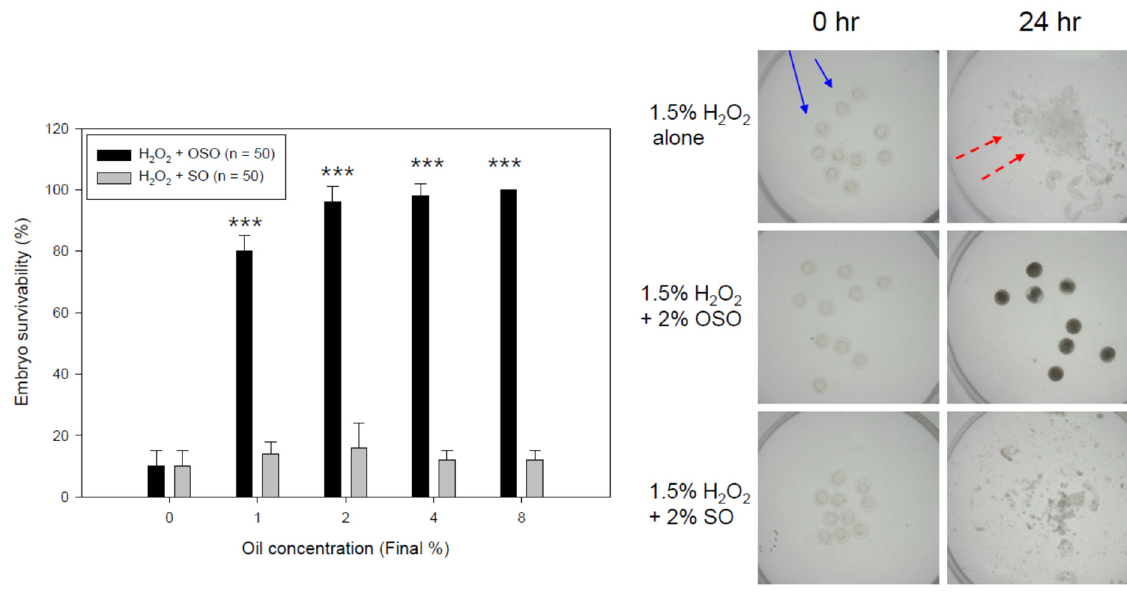
Figure 8. Embryo-protective effect of ozonated sunflower oil (OSO) in the presence of H 2 O 2 . *** p < 0.005. Blue solid arrow indicates zebrafish embryo at 0 h and red dotted arrow indicates debris of embryo at 24 h after explosion.